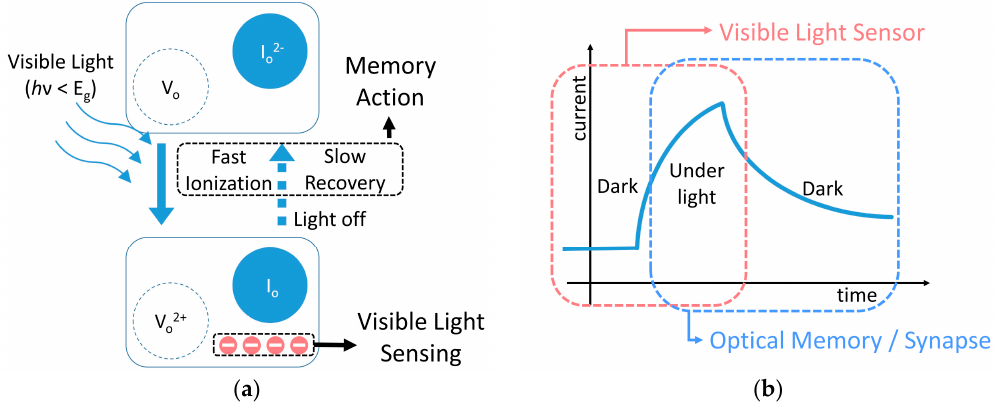
Figure 4. ( a ) Conceptual diagram to describe an optical memory-action and light-reactivity through the ionization of oxygen defects. ( b ) Indication of functional regions of the current as a function of time for each device.